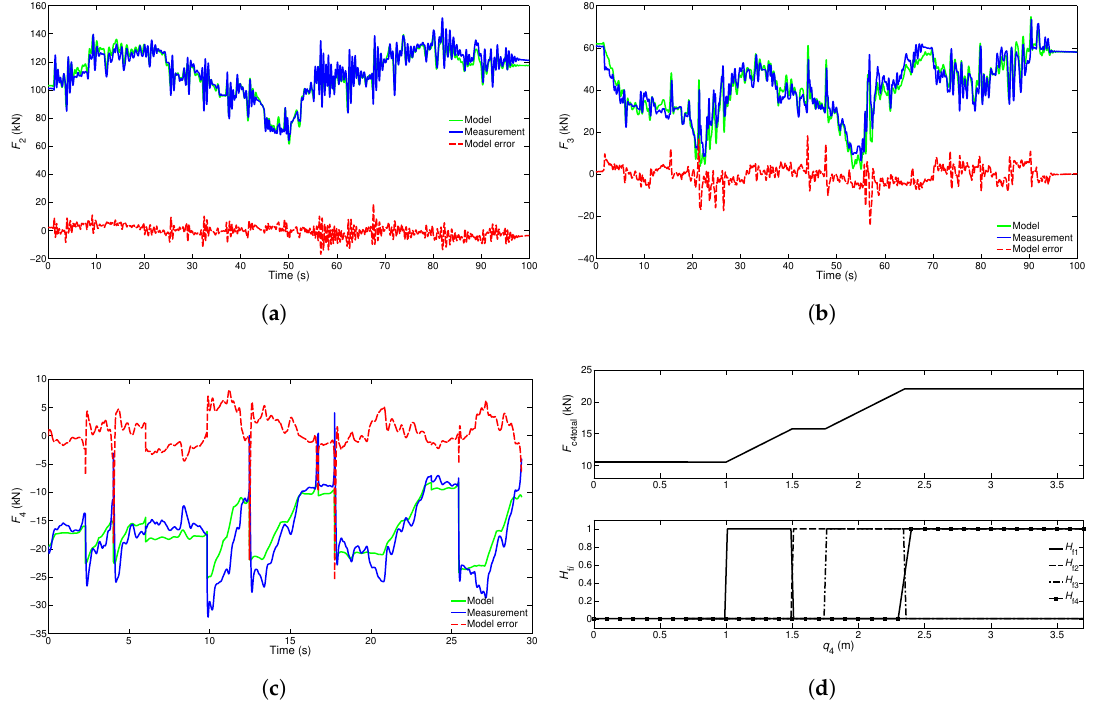
Figure A2. Cylinder forces F i (kN) as a function of time (s): ( a ) Lift cylinder force F 2 ; ( b ) tilt cylinder force F 3 ; and ( c ) extension cylinder force F 4 . The designed extension friction force F c4total , where the Heaviside functions create the steps, is shown in ( d